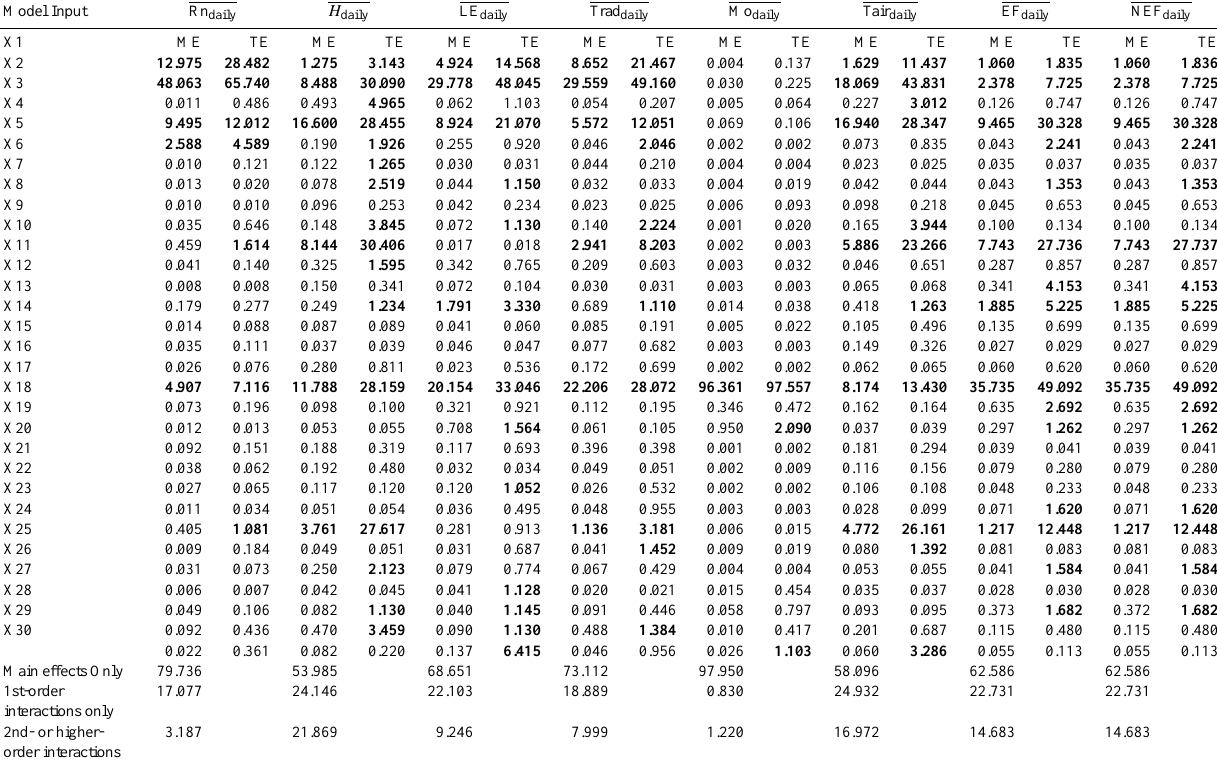
Table 5. Summarised results from the implementation of the BACCO GEM-SA method on the different outputs simulated by SimSphere using the uniform PDFs. Computed main (ME) and total effect (TE) indices by the GEM tool (expressed as %) for each of the model parameters are shown, whereas the last three lines summarise the percentages of the explained total output variance of the main effects alone and after including the interaction effects. Input parameters with a variance decomposition of greater than 1% are highlighted in bold